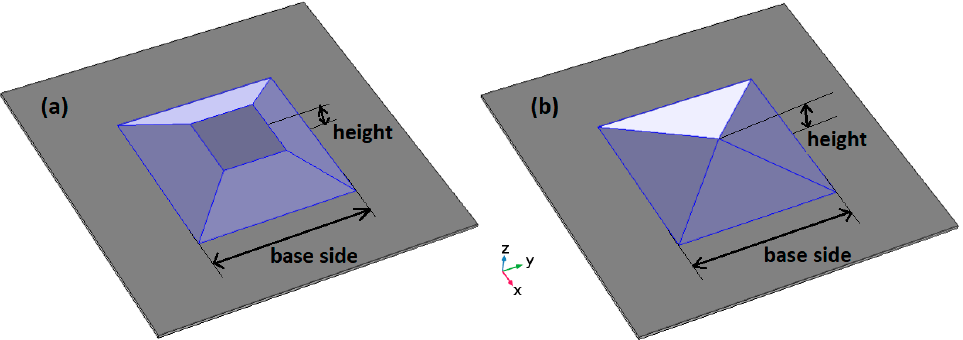
Figure 2. Schematic presentation of modeled QD geometry: ( a ) truncated pyramid and ( b ) pyramid.